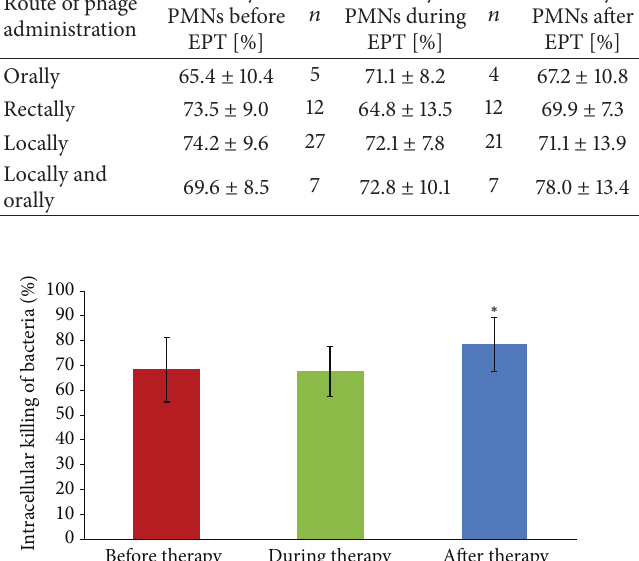
Table 2: Intracellular killing of pathogenic strains depending on the route of administration of phage preparations. Route of phage